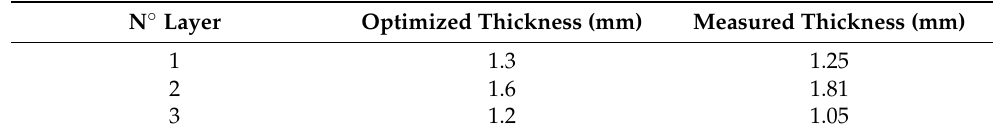
Table 4. Composition of the thickness measured for each printed